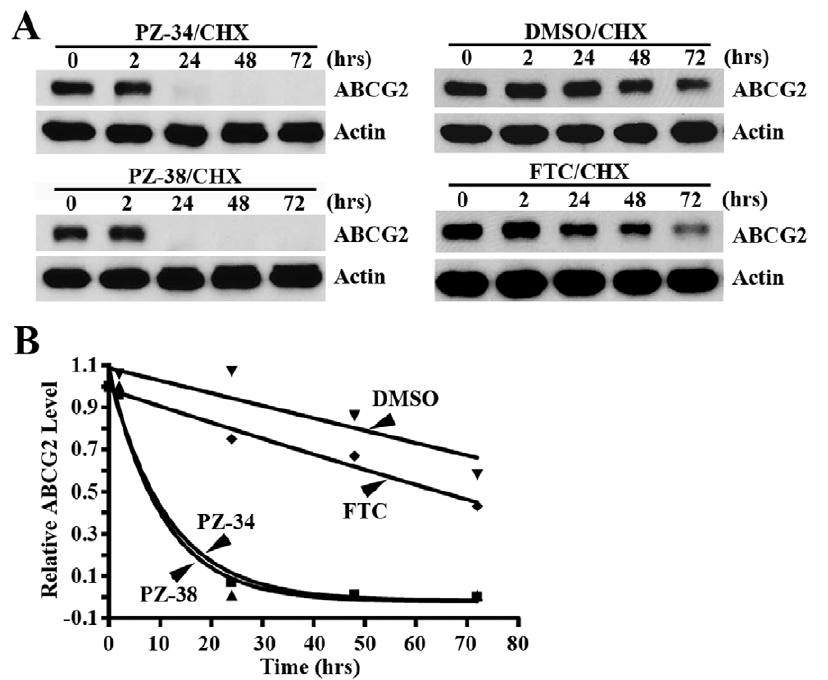
Figure 6. Effect of PZ-34 and PZ-38 on ABCG2 stability. A, Western blot analysis. HEK293/ABCG2 cells were first treated with 5 m g/ml cycloheximide (CHX) followed by addition of 3 m M of PZ-34, PZ-38, FTC, or DMSO control for various times. The cells were then harvested for Western blot analysis of ABCG2 probed with monoclonal antibody BXP-21. Actin was used as a loading control. B, half-life of ABCG2. ABCG2 levels on Western blot as shown in panel A were determined using Scion Image and plotted against time of treatment. Data shown are mean 6 S.D of three experiments.